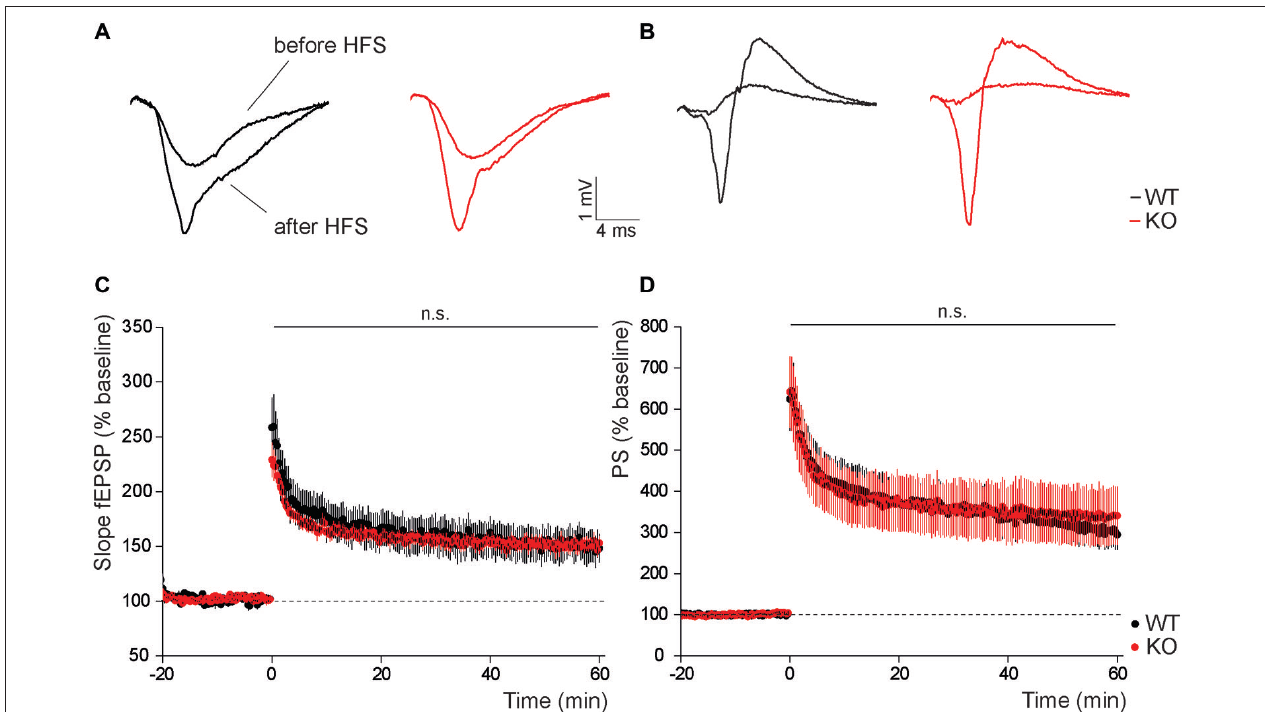
radiatum of CA1 after high frequency stimulation is unaltered in KO slices ( p > 0.05; n = 11/11). (D) Similarly, no genotype-dependent difference was observed in the potentiation of the population spike amplitude recorded in the stratum pyramidale after high frequency stimulation ( p > 0.05; n =